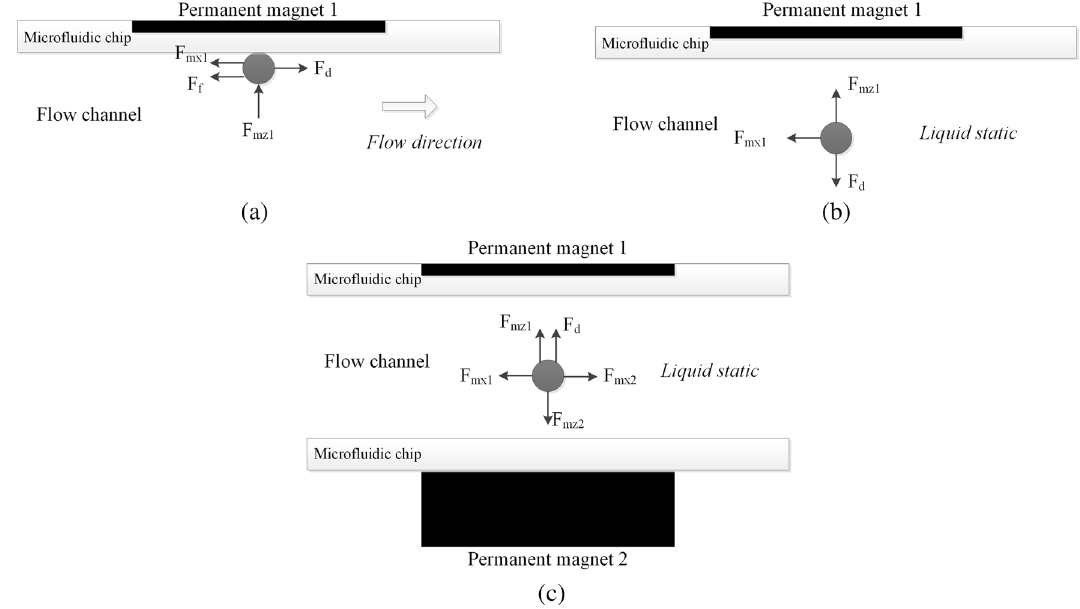
Figure 10. Force analysis of preset magnetic beads. ( a ) Preset magnetic bead capture. ( b ) Upward mixing motion. ( c ) Downward mixing